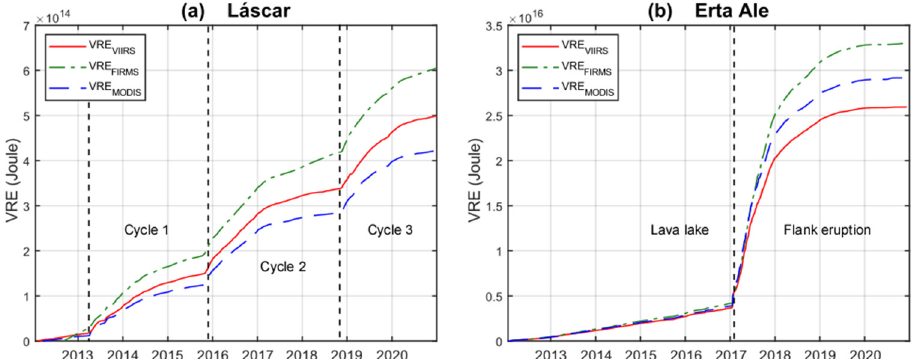
Figure 10. Cumulative Volcanic Radiative Energy (VRE) calculated from VRP (and FRP) by trapezoidal rule for integration: the red line represents VRE VIIRS , the blue dashed line VRE MODIS and the green dashed line VRE FIRMS . ( a ) Láscar; ( b ) Erta Ale. Dashed black lines are the limits of the three cycles of Láscar and the two phases of Erta Ale’s eruptive history considered in this paper. Table 3. Table displaying cumulative total VRE for every Láscar cycle and Erta Ale phase. In grey cells, there are the same values calculated for the period analyzed in this work (2012–2020).